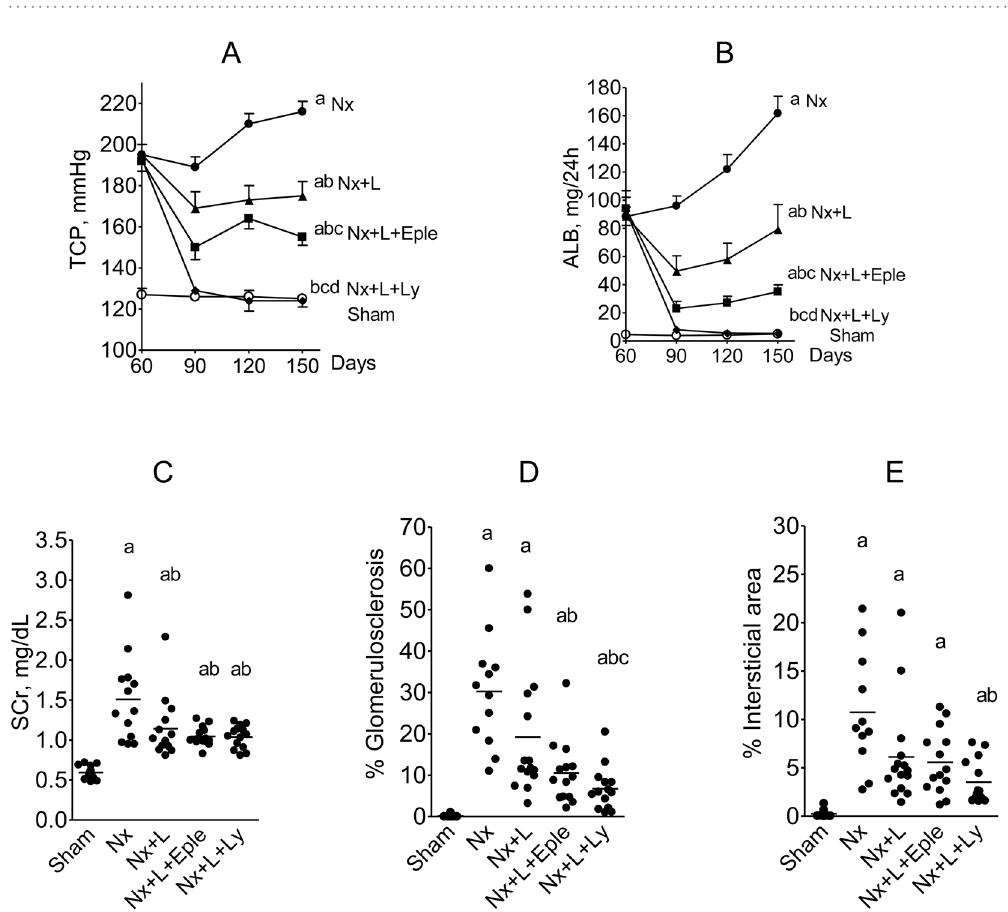
Figure 5. Tail-cuff pressure ( A ), albumin excretion rate ( B ), serum creatinine ( C ), percentage of glomeruli with sclerotic lesions ( D ) and fractional cortical interstitial area ( E ) 150 days after renal ablation in Protocol 2 (late treatment). a p < 0.05 vs. Sham, b p < 0.05 vs. Nx, c p < 0.05 vs. Nx +